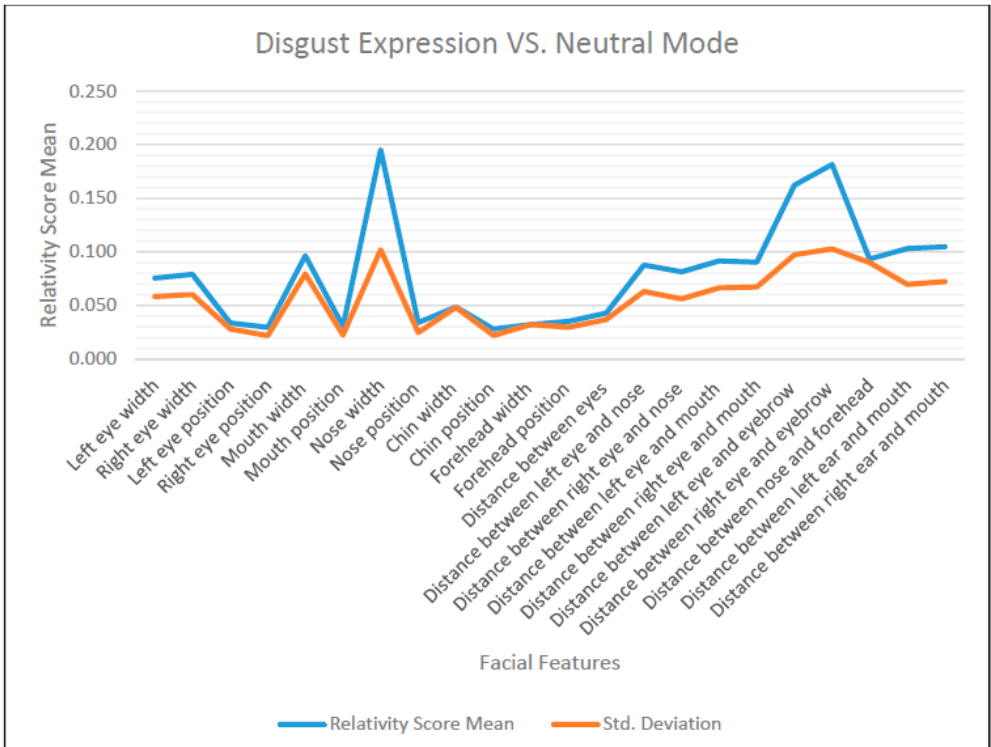
Figure 18. The means of RSS between disgust expression and neutral mode of facial features for 36 subjects.